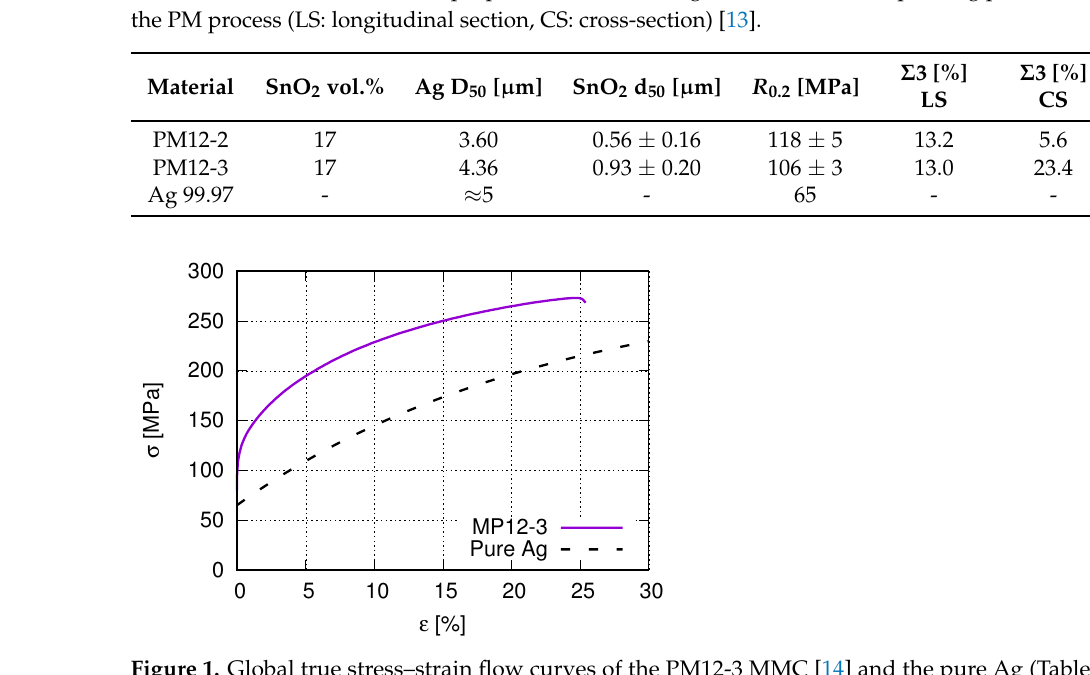
Figure 1. Global true stress–strain flow curves of the PM12-3 MMC [14] and the pure Ag (Table 1) under